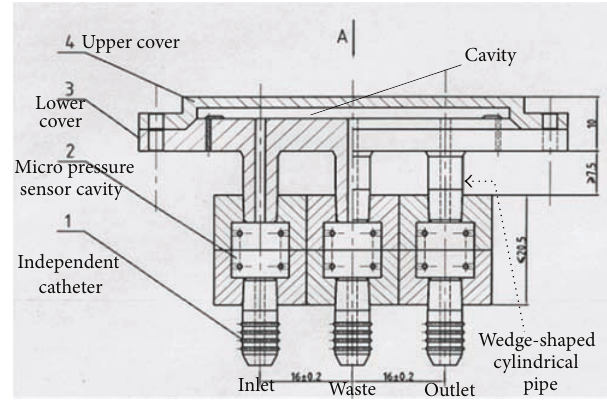
Figure 4: The assembly drawing of cell culture